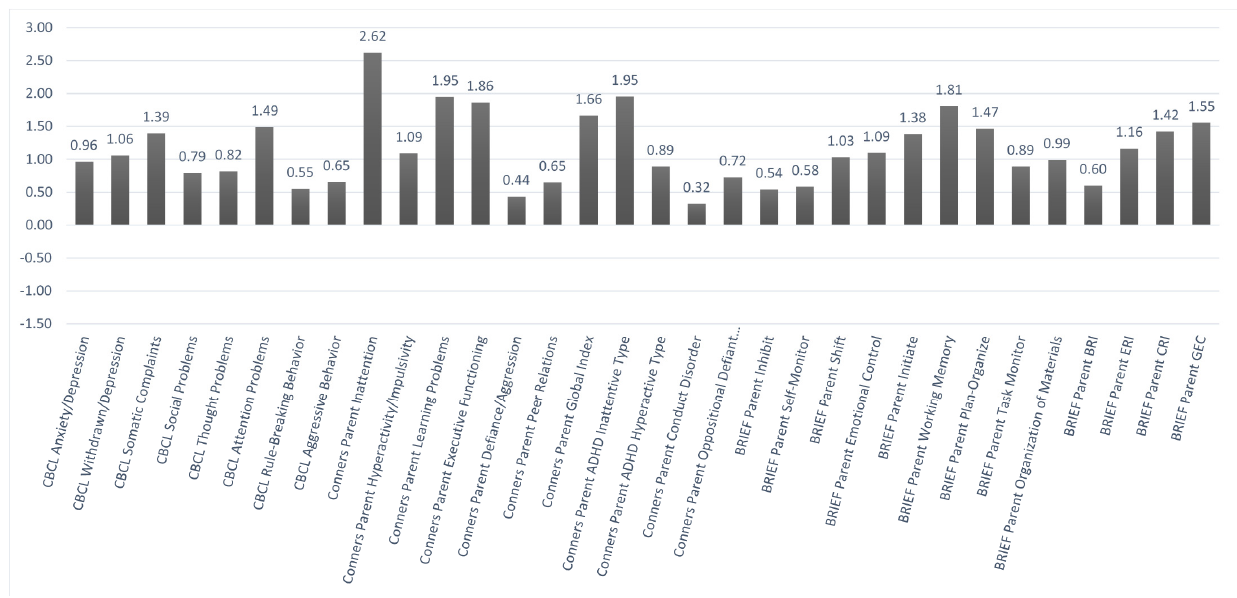
Figure 2. Behavioral Self-Report Baseline Data. n = 17. The y-axis is based on z -scores (M = 0, SD = +/- 1). Higher scores indicate the reporting of greater problem. Revised Child Manifest Anxiety Scale (RCMAS); Child Depression Inventory (CDI); Behavior Rating Inventory of Executive Functioning (BRIEF); Behavior Regulation Index (BRI); Emotion Regulation Index (ERI); Cognitive Regulation Index (CRI); Global Executive Composite (GEC).